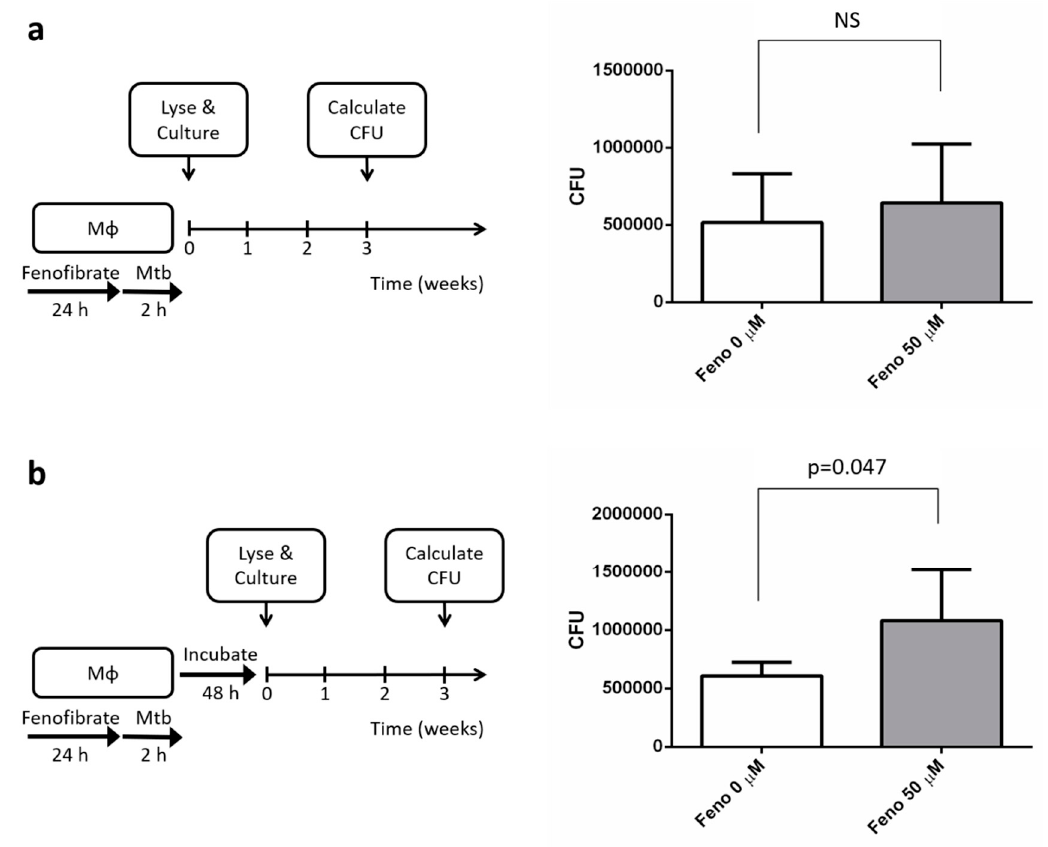
Figure 3. The effect of fenofibrate treatment on the survival and growth of Mycobacterium tuberculosis ( Mtb ) in human macrophages (M φ ). ( a ) Human macrophages were treated with fenofibrate (50 µM) for 24 h, infected with Mtb (multiplicity of infection, MOI = 5) for 2 h, and then lysed. The lysates were cultured for Mtb on 7H11 agar for 3 weeks, after which the numbers of colony-forming units (CFUs) were calculated. ( b ) Human macrophages were treated with fenofibrate (50 µM), infected with Mtb , and then washed to remove unbound mycobacteria. After 48 h of incubation, the survival of Mtb in human macrophages was determined by Mtb culture and CFU determination. Fenofibrate significantly promoted the intracellular survival of Mtb. Data are shown as means ± SEMs ( n = 5 per group), and statistical difference was analyzed with the Mann–Whitney test. NS: Not Significant.